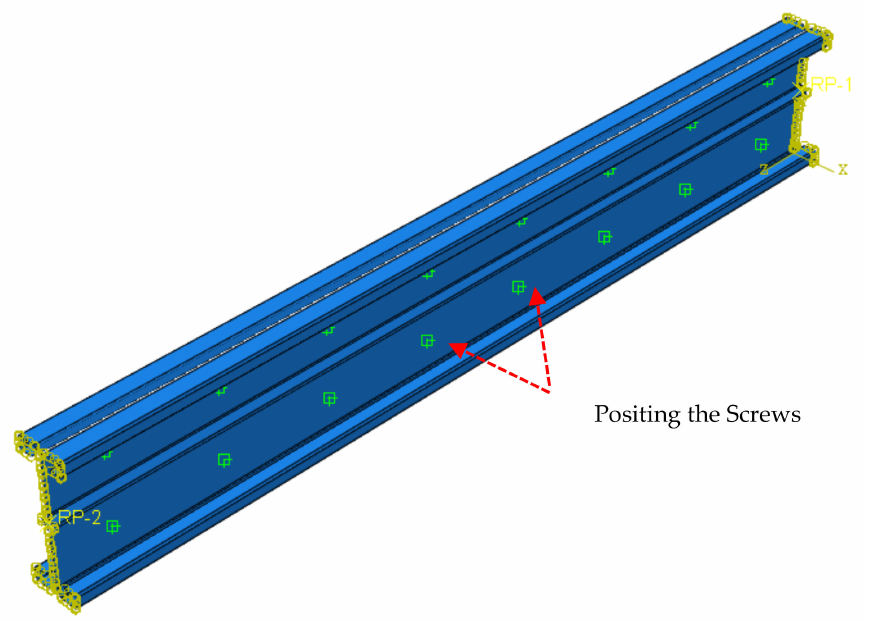
Figure 12. Arrangement of screws and boundary conditions applied in the FE model of BISCS-5.